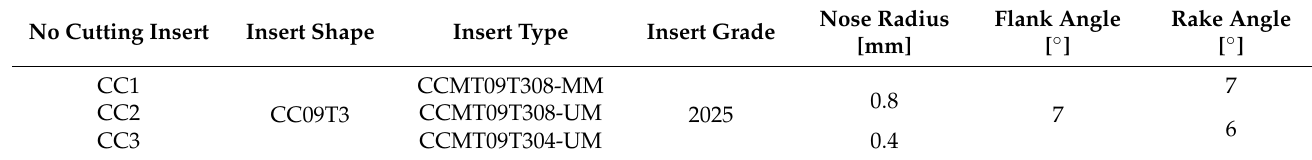
Table 2. Cutting inserts shape, type and grade for the turning of samples with the X2CrNiMoCuN